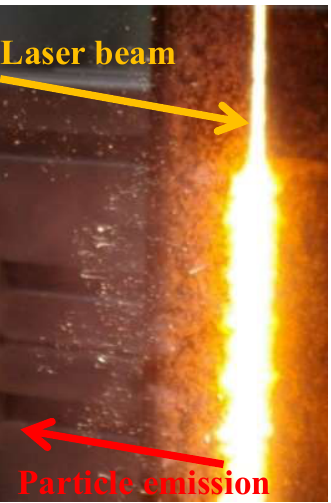
Figure 4. Emission of particles from the irradiated surface produced by thermal stresses induced in the black granite.